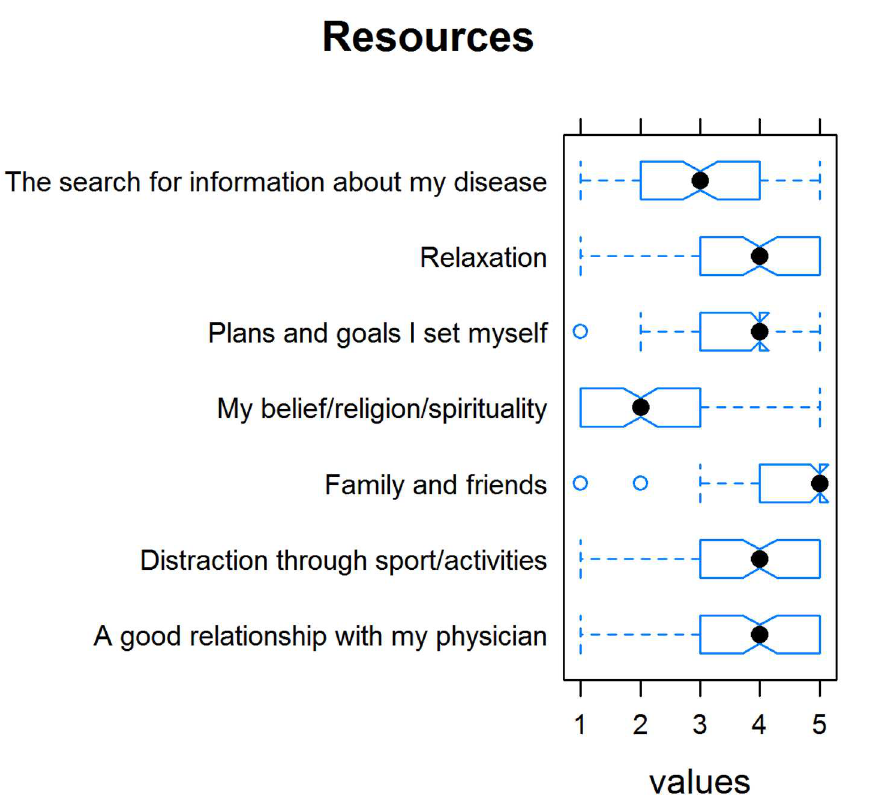
Fig 9. Tukey’s box plots with a notch depicting patient resources and their